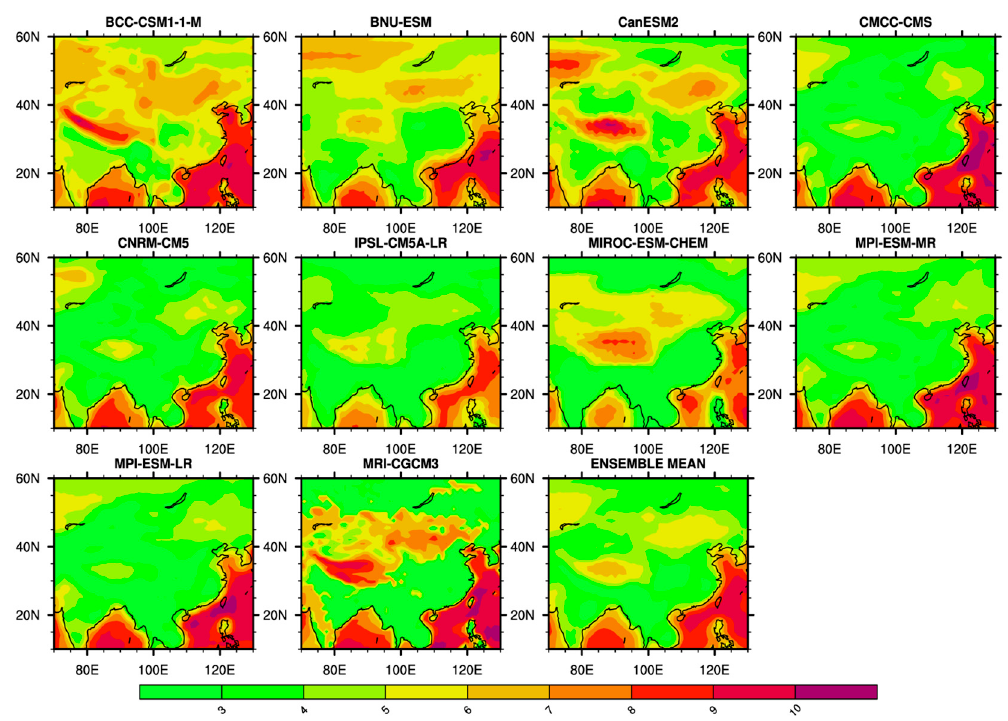
Figure 2. Mean wind speed in m / s extrapolated to 90 m above ground level height for the historical period of 1950–1980 for the selected models and the ensemble mean.